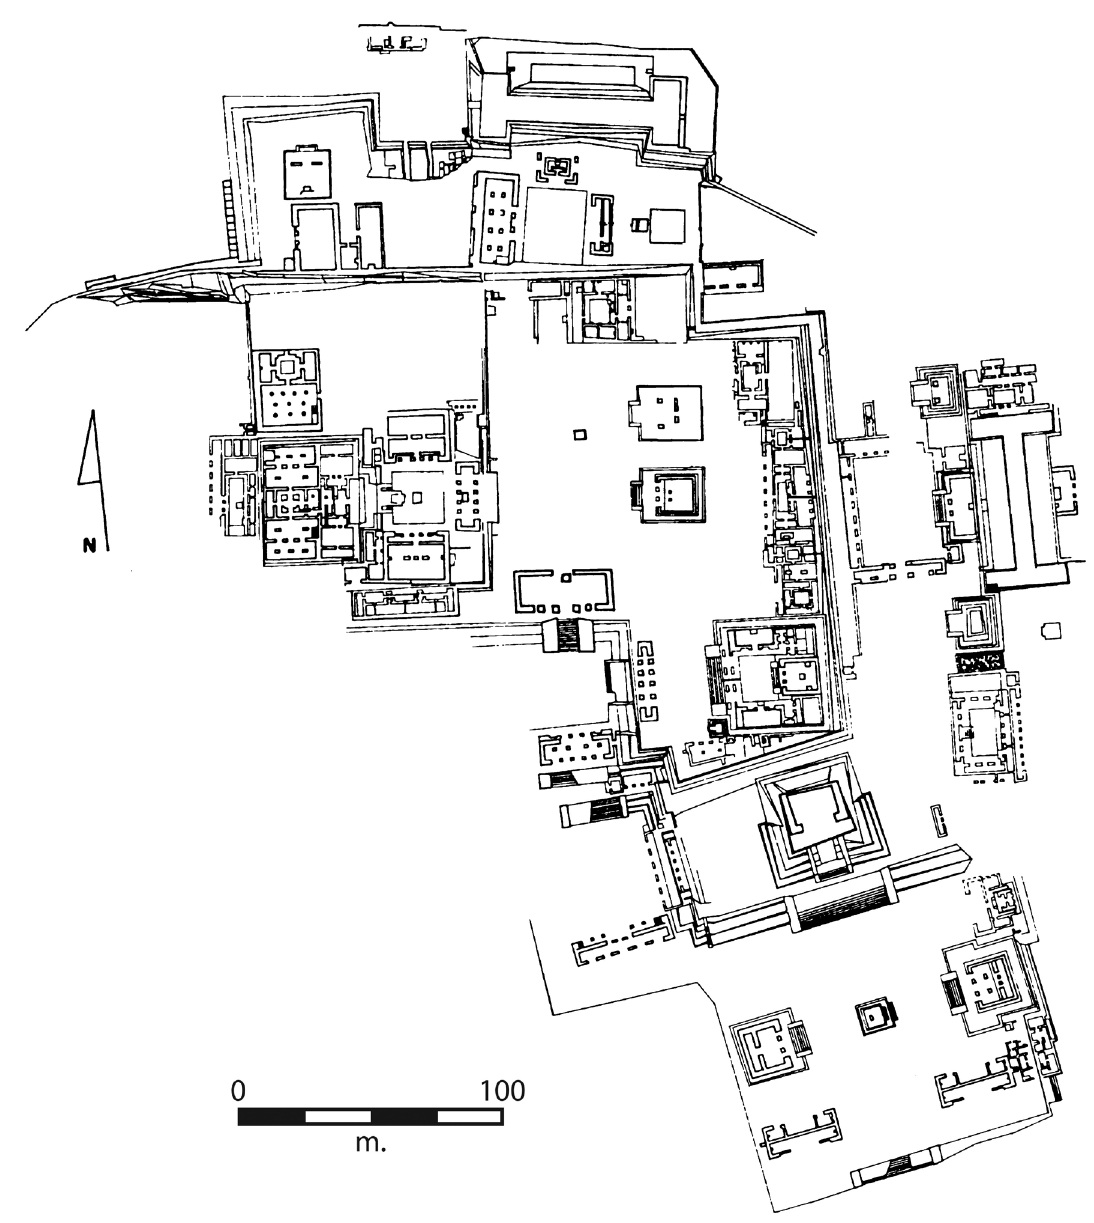
Figure 6. Xochicalco plan, showing features of the Mesoamerican planning principles. Modified after (Molina & Kowalski,